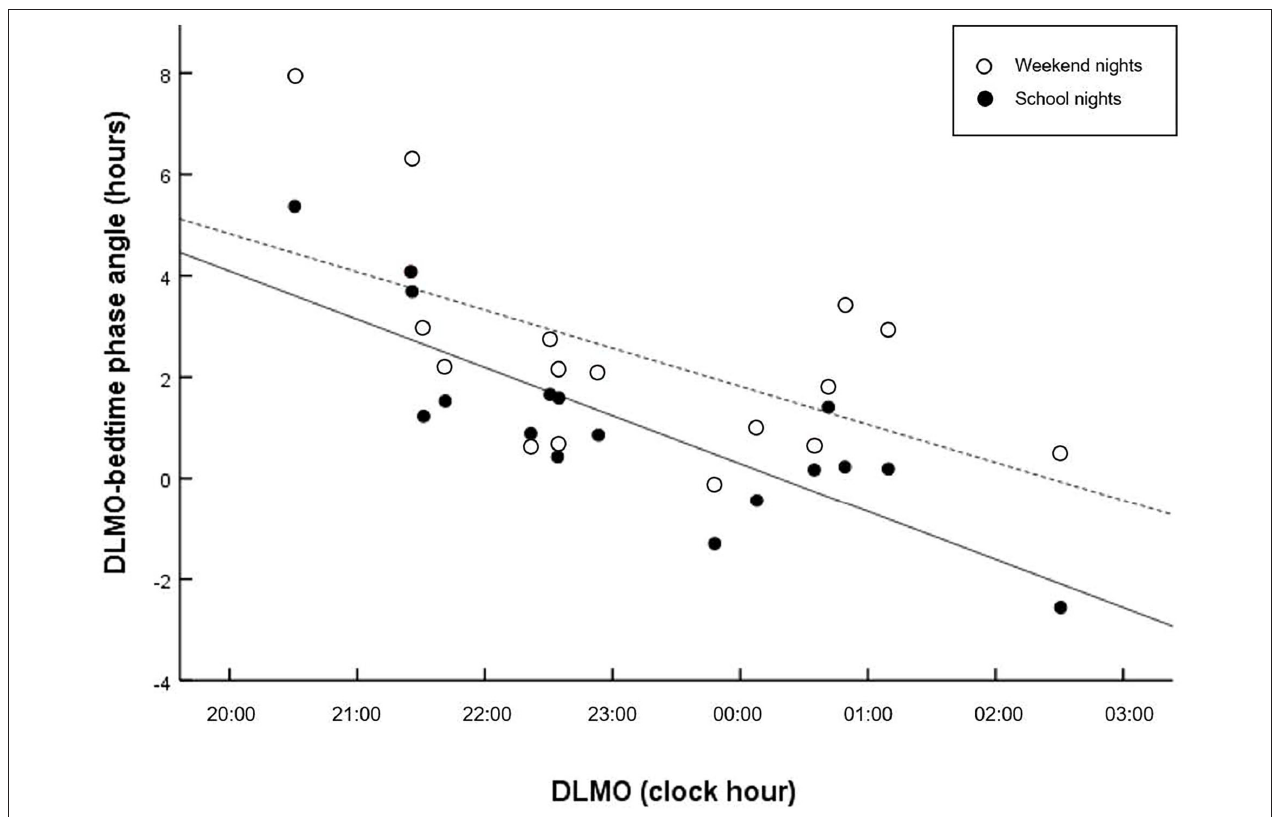
FIGURE 1 | Scatter plots of phase angle relative to DLMO. Regressions are computed separately for school nights (solid line) and weekend nights (dashed lines). Shorter interval (phase angle) between circadian phase and bedtime is related to later circadian phase on school nights ( r = − 0.814, p < 0.001), and weekend nights ( r = − 0.583, p =